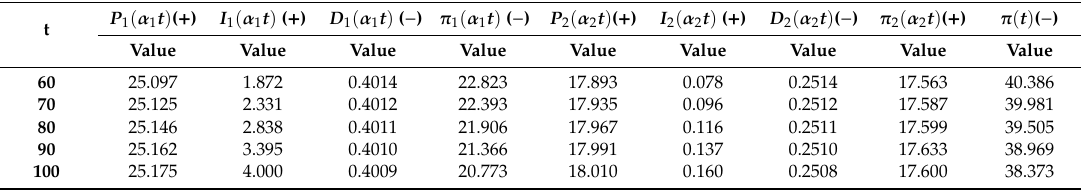
Table 6. Sensitivity analysis α 1 : α 2 = 70%:30%. Unit: million